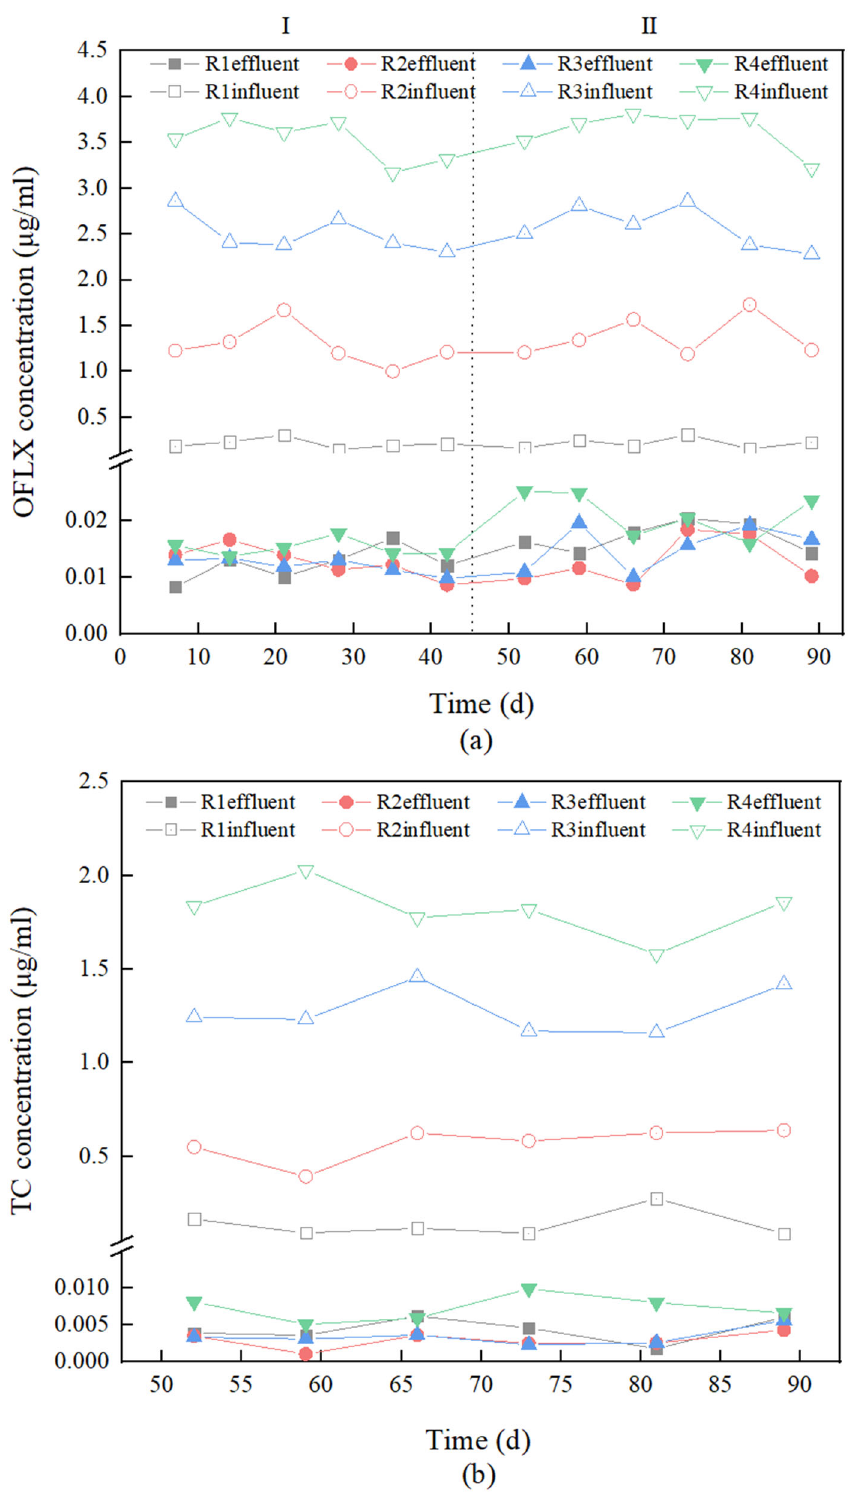
Figure 3. ( a ) Removal performance of ofloxacin (OFLX). ( b ) Removal performance of tetracycline (TC).